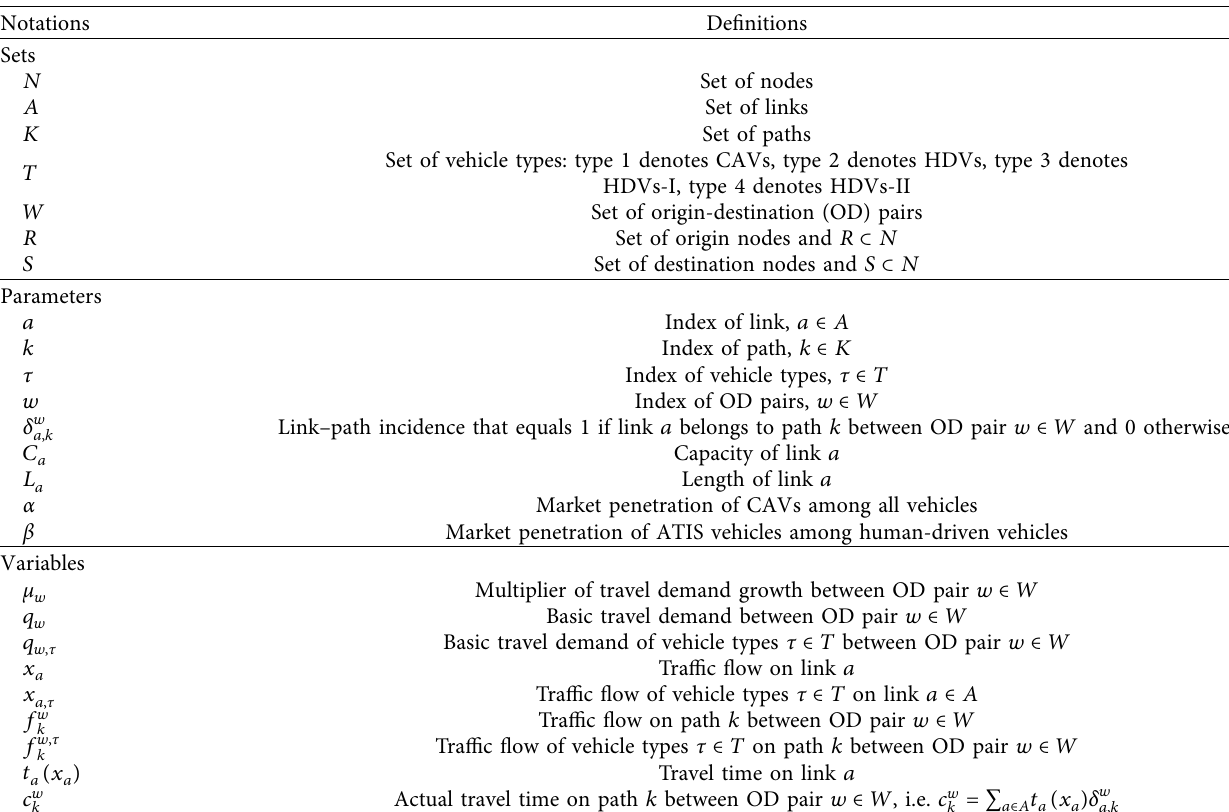
Table 1: Notation